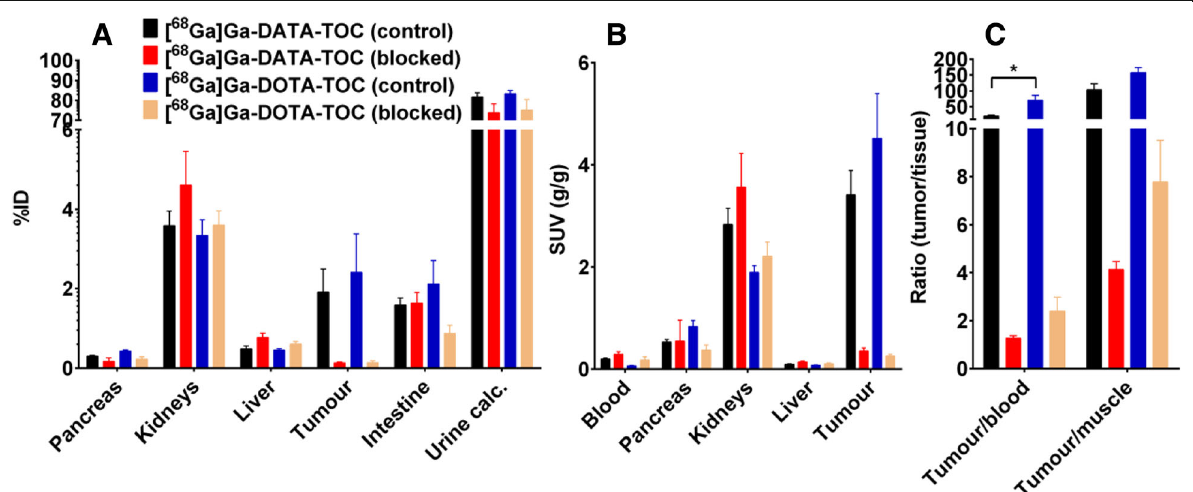
Fig. 5 Biodistribution of [ 68 Ga]Ga-DATA-TOC and [ 68 Ga]Ga-DOTA-TOC in selected organs and tissues expressed as a percent of injected activity (%IA), b SUV in g/g, and c tumour-to-tissue ratios (SUV/SUV) 60 min after single intravenous injection of [ 68 Ga]Ga-DATA-TOC (control n = 9, blocked n = 8) and [ 68 Ga]Ga-DOTA-TOC (control n = 5, blocked n = 7) in MPC-mCherry tumour-bearing NMRI-nude mice; blocked animals received